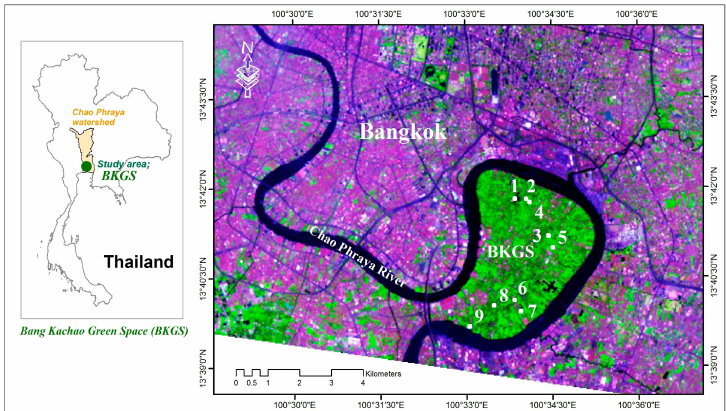
Figure 1. Satellite LANDSAT 7 false color image of Bangkok and the Chao Phraya River showing location of the Bang Kachao Green Space (BKGS), 25 April 2012. Locations of the nine sample plots were in rehabilitation forest (plots 1, 2, 3 and 6), home-garden agroforestry (plots 4 and 8), mangrove forest (plot 5) and park (plots 7 and